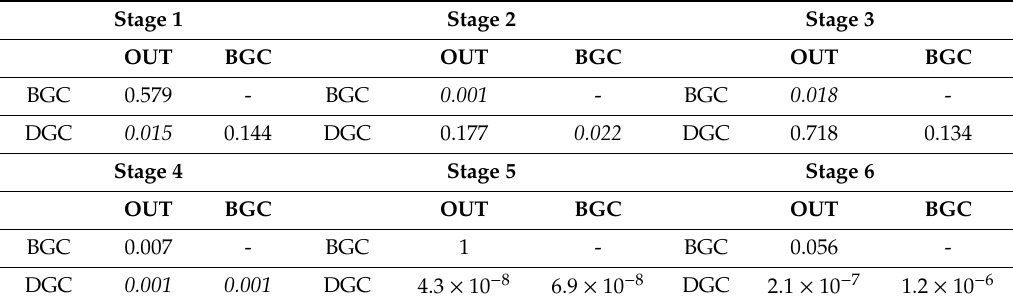
Table 3. Pairwise comparisons between bacterial aerosol (BA) concentrations on di ff erent stages of ANDI.